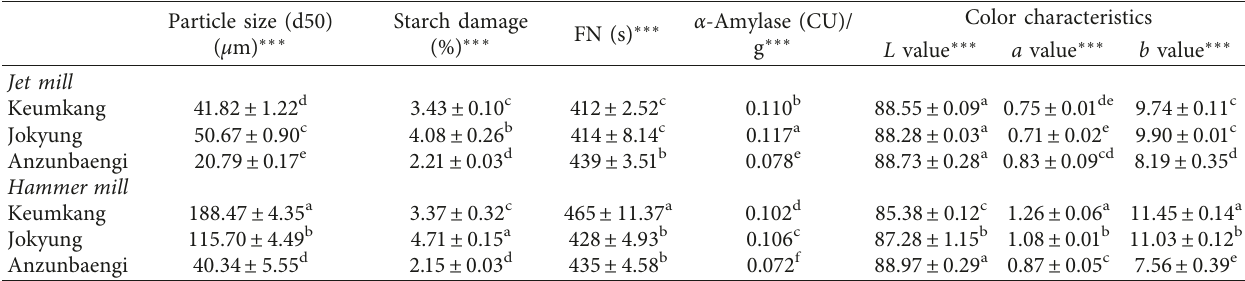
Table 2: Median particle size (d50), starch damage, falling number (FN), and color characteristics of WWFs milled with jet mill and hammer